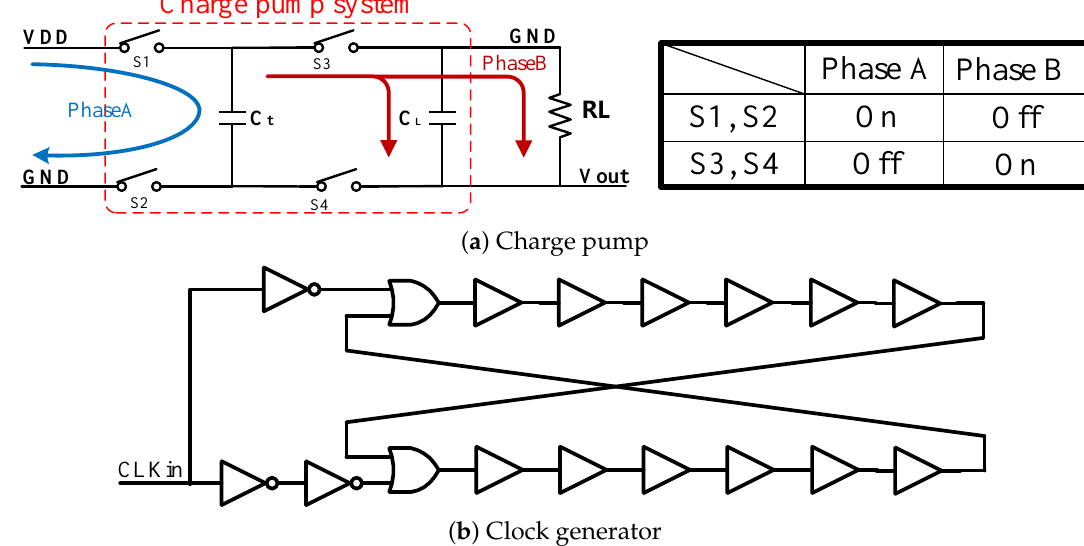
Figure 7. ( a ) Architecture of the charge pump design. There are two phases in the entire working flow: (i) Phase A is the input phase (highlighted in blue) while the battery charges the whole system; (ii) Phase B (highlighted in red) is the charge balancing between C t and C L . ( b ) Architecture of the non-overlapping clock generator, which is used to meet the requirement for the loop control. VDD is the power voltage of the circuit and RL represents the load of the charge pump.